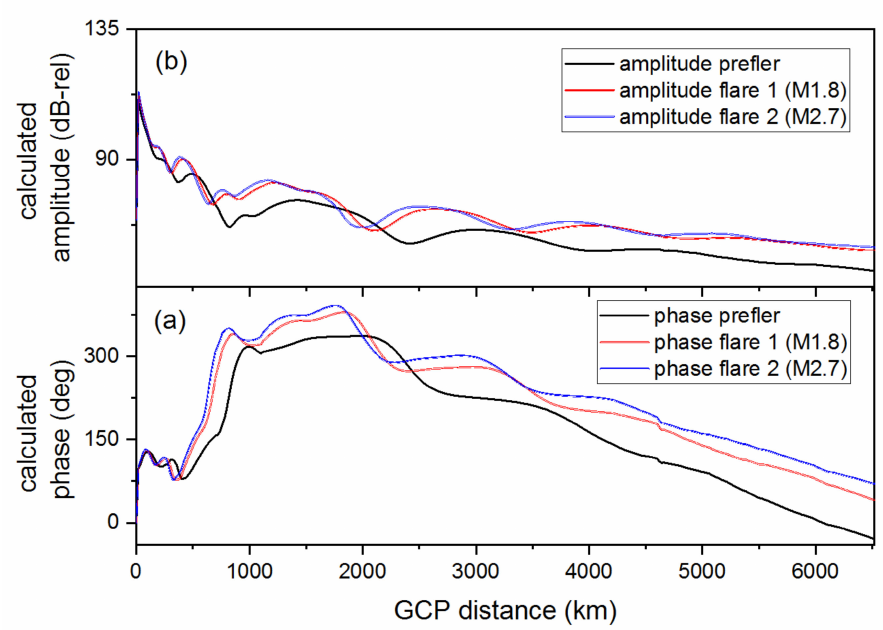
Figure 7. The phase ( a ) and amplitude ( b ) of the NAA/24.0 kHz signal along the GCP distance from Maine, USA, to BEL VLF station, Belgrade, obtained for quiet and disturbed ionospheric state during SFs on 12 June